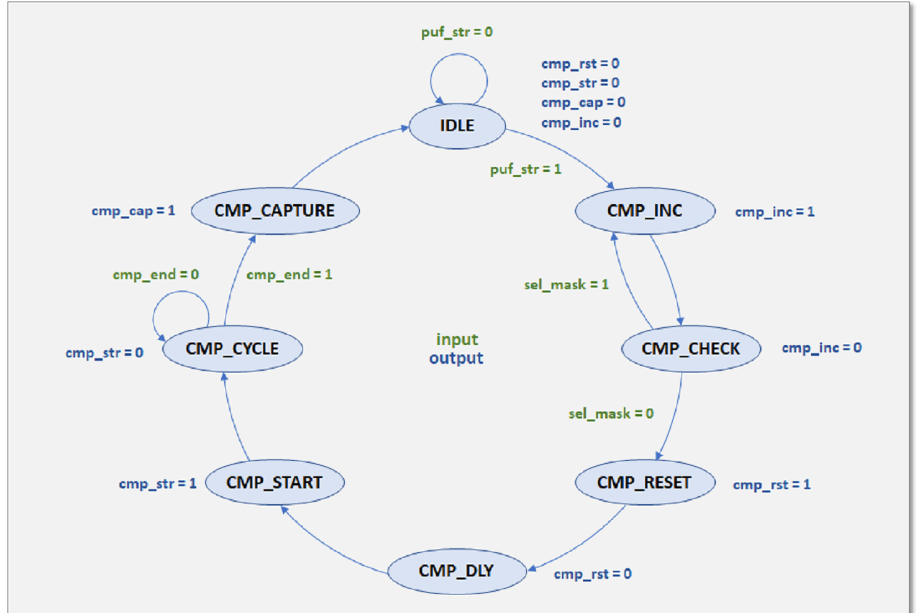
Figure 4. State diagram of the FSM included in the control